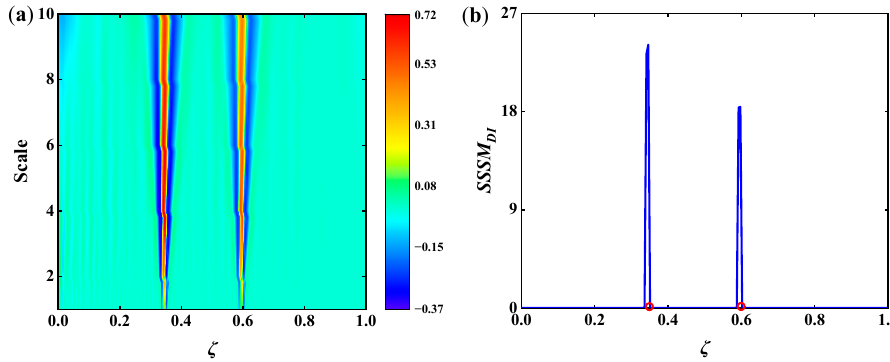
Figure 20. Identification results of cracked cantilever beam under scenario II when γ = 10%: ( a ) CS ( b, s ) ; ( b ) Damage index SSSM DI .